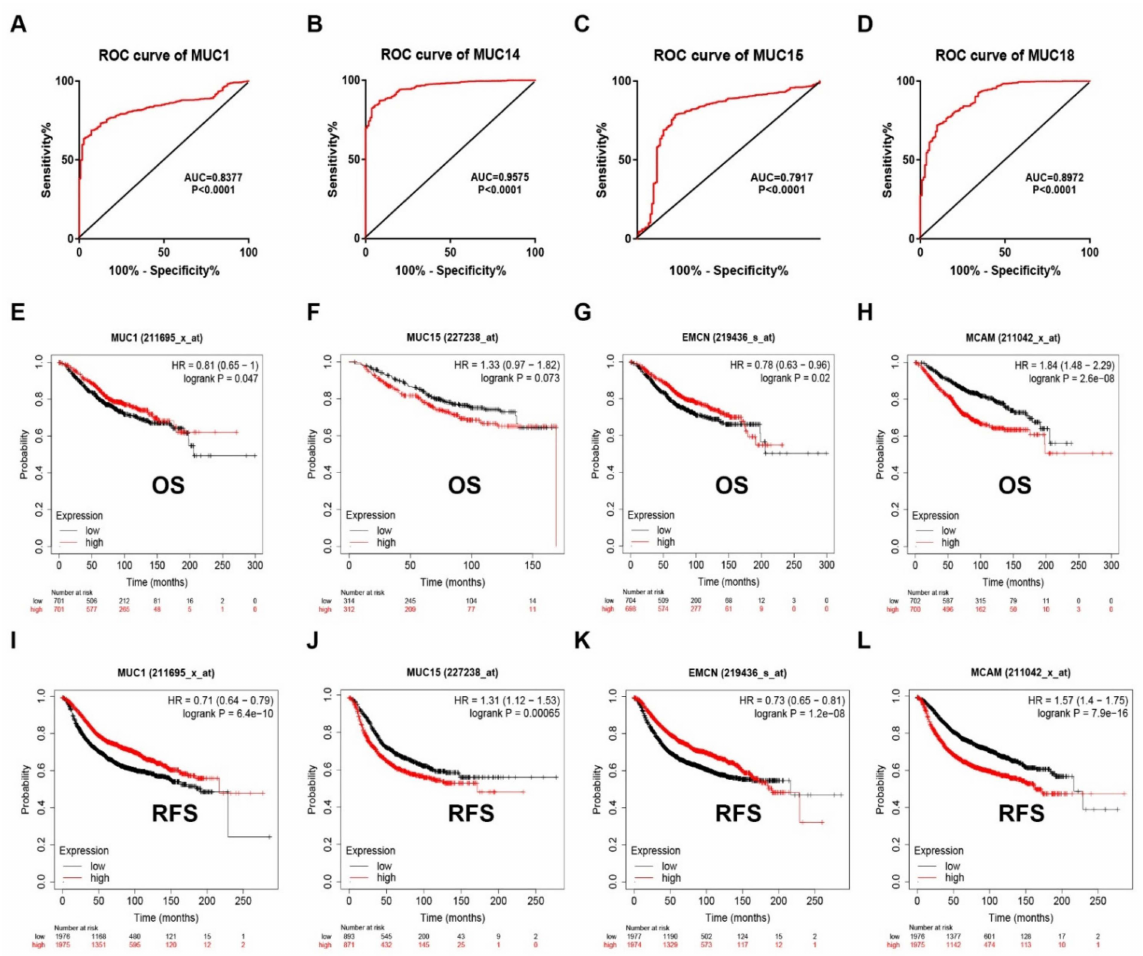
Figure 3. The diagnostic and prognostic values of MUC1, MUC14, MUC15 and MUC18 in breast cancer. ( A ) The ROC curve of MUC1 ( A ), MUC14 ( B ), MUC15 ( C ) and MUC18 ( D ) in breast cancer. The OS curve of MUC1 ( E ), MUC15 ( F ), MUC14 ( G ) and MUC18 ( H ) in breast cancer. The RFS curve of MUC1 ( I ), MUC15 ( J ), MUC14 ( K ) and MUC18 ( L ) in breast cancer. “ p < 0.05” was considered as statistically